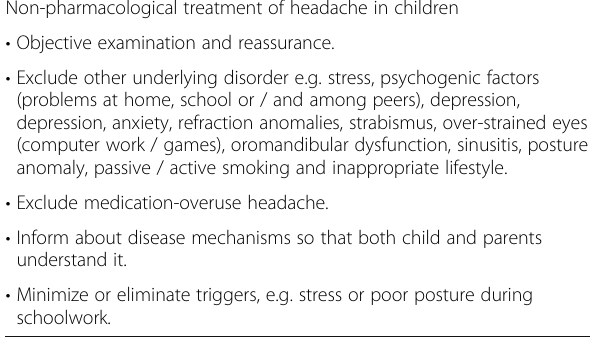
Table 22 Non-pharmacological treatment of headache in children